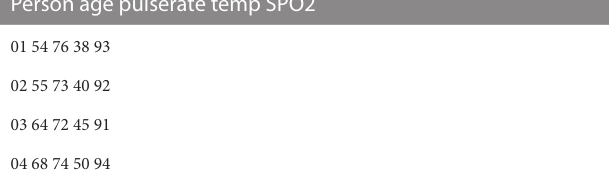
TABLE1 sampledataset. Person age pulserate temp